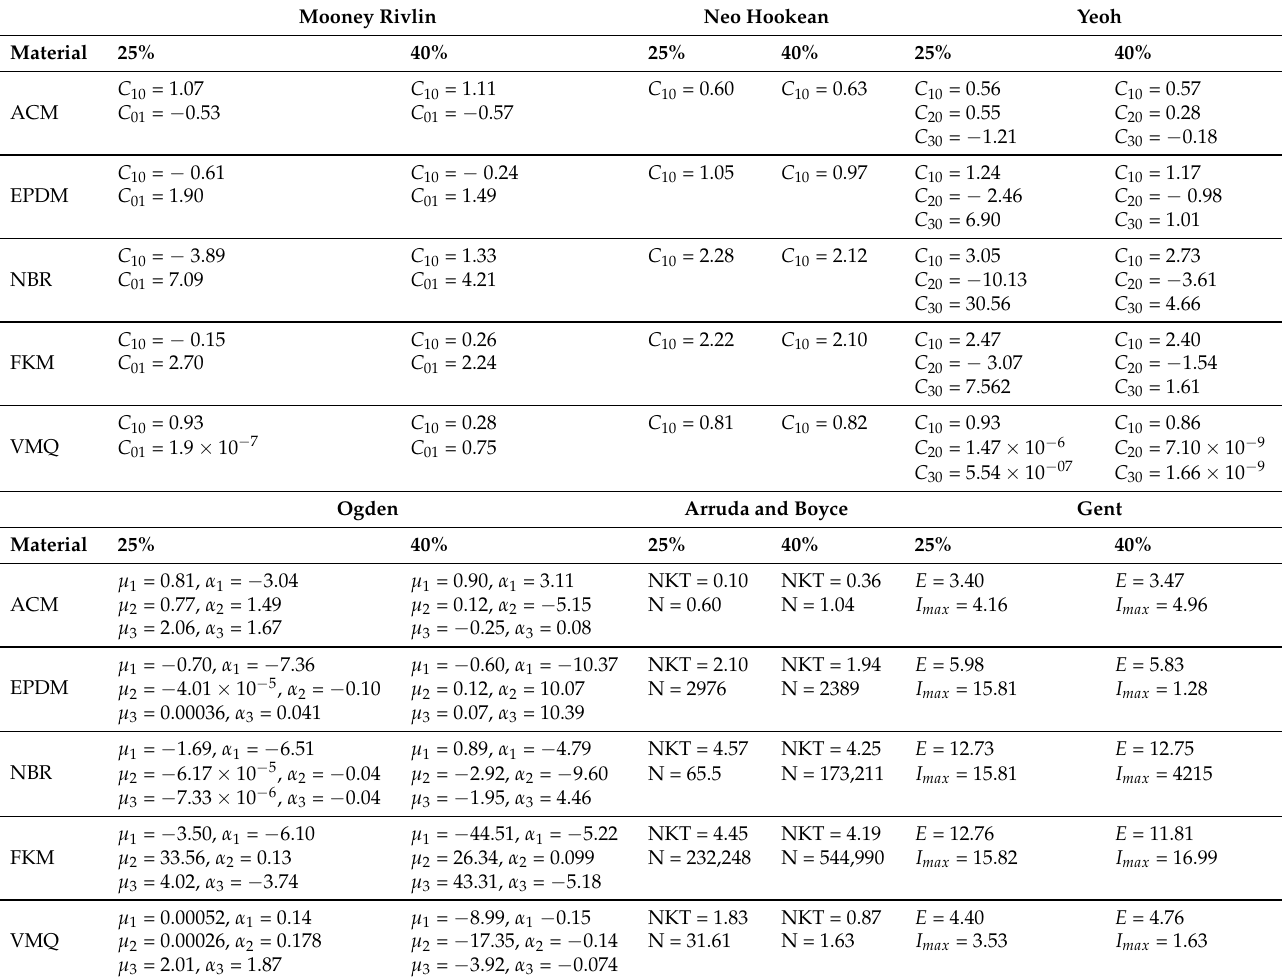
Table 1. Hyperelastic Model Constant Values for the selected RLM. Mooney Rivlin Neo